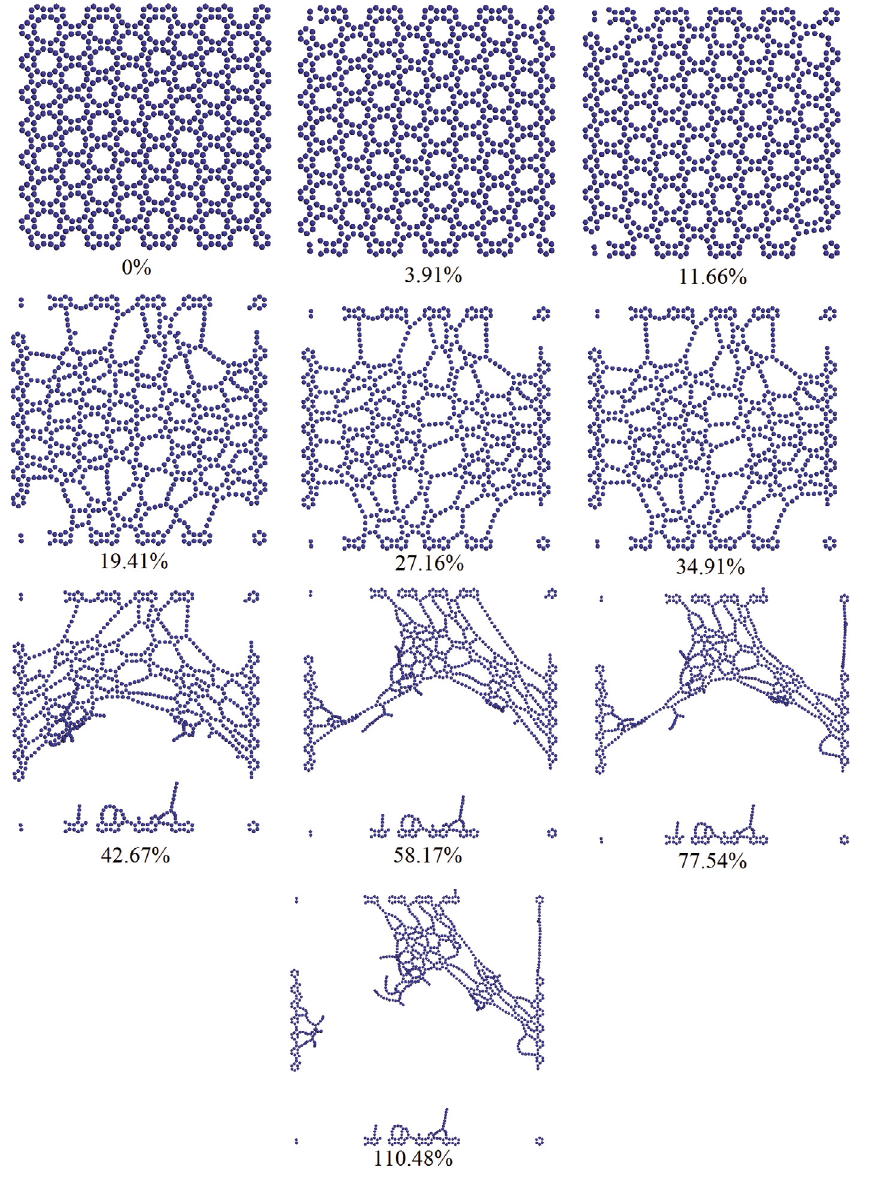
Figure 12: The shapes of a 50×50 Å 2 graphenylene under bi-directional loading at different strains